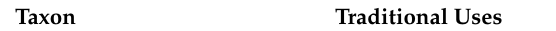
Table 2. Traditional uses, biological activities and specialized metabolites isolated from Teucrium taxa used in the traditional medicines of the Kurdistan Region, Iraq, and other